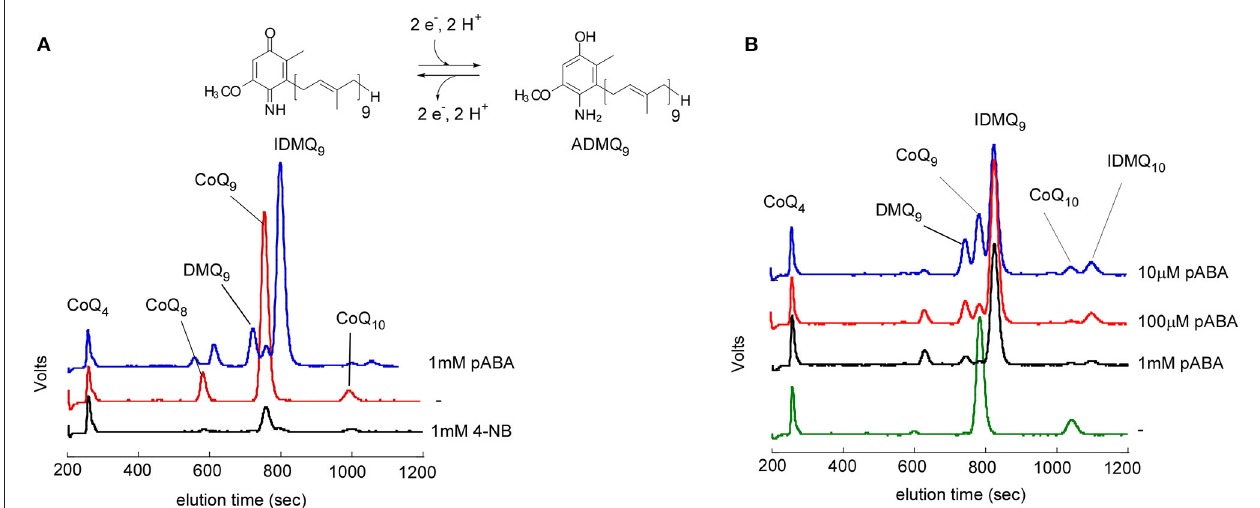
FIGURE 2 | Effect of pABA on mammalian cell lines. Analysis of cellular lipid extracts by high performance liquid chromatography coupled to electrochemical detection with a precolumn electrode set in oxidizing mode. NIH/3T3 fibroblasts (A) and CHO cells (B) were grown for one week in the absence ( − ) or with the indicated concentrations of pABA or 4-NB. CoQ 4 was used as an internal standard. The peaks corresponding to CoQ 9 and CoQ 10 , 4-imino-6-demethoxyubiquinone 9 (IDMQ 9 ) and IDMQ 10 , 6-demethoxyubiquinone 9 (DMQ 9 ) are indicated. The chemical structure of IDMQ 9 and ADMQ 9 are shown.